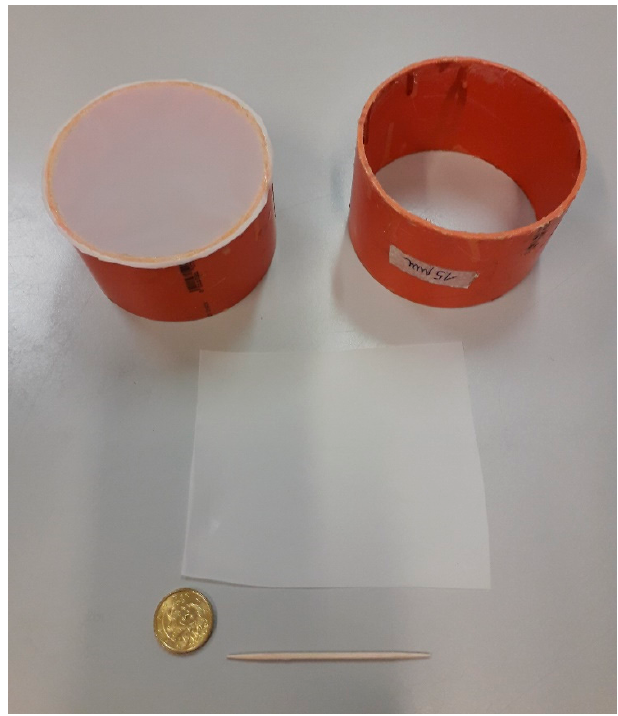
Figure 1. Tissue sieve made with nylon mesh. From bottom to top: toothpick and 100-cm 2 -piece of nylon mesh; PVC ring and tissue sieve ready for use.